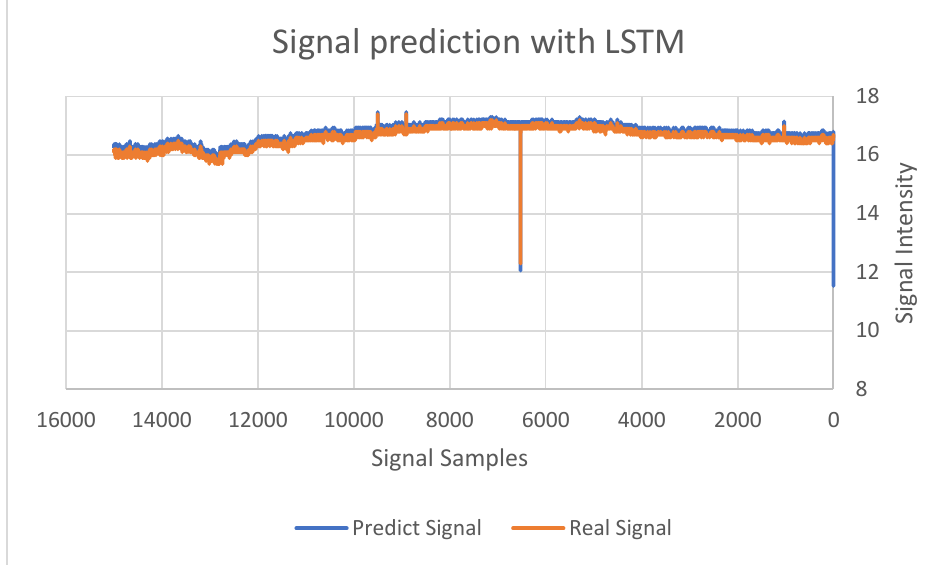
Figure 4. Comparison of the actual and predicted signal for one month. Reprinted with permission from ref. [1]. Copyright 2021 IEEE.